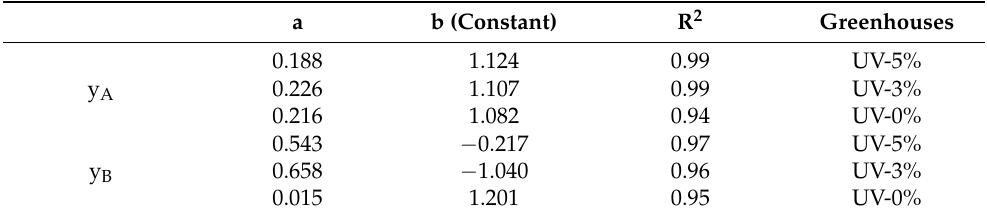
Table 2. Variables and constant numbers expressing the linear regression representing the evolution of UV radiation transmissivity of the covering materials after being exposed in field conditions (months). a b (Constant)